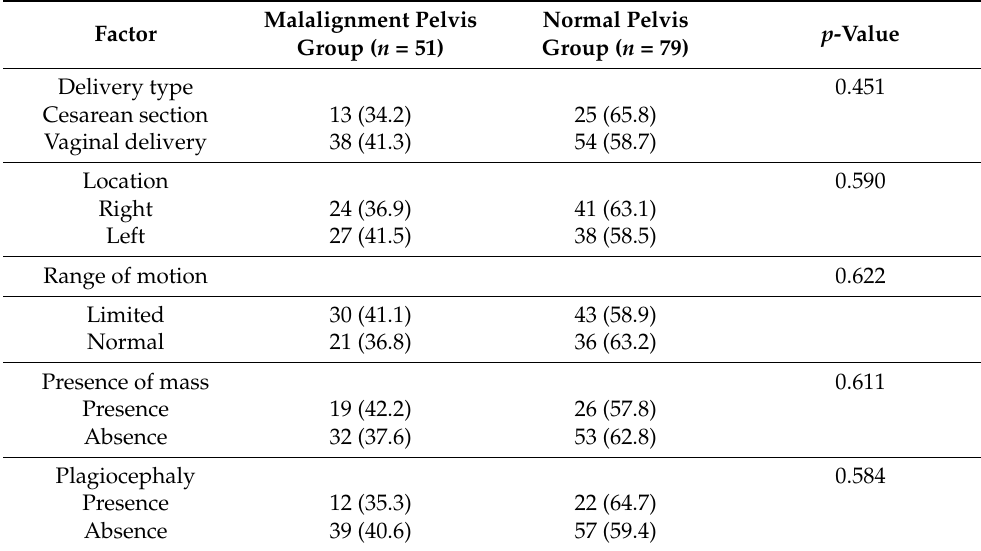
Table 4. Comparison according to the pelvis alignment status group at long-term follow-up.